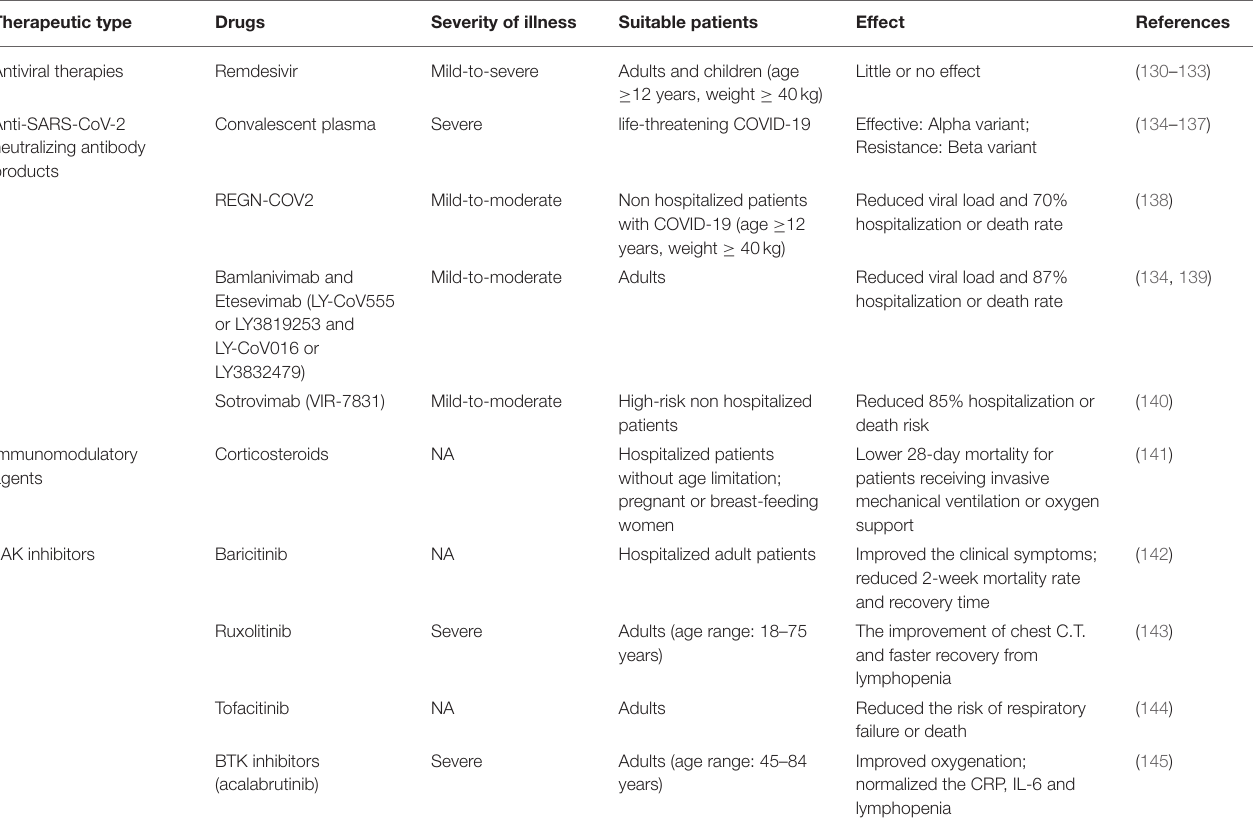
TABLE 2 | The best clinical and therapeutic approaches for